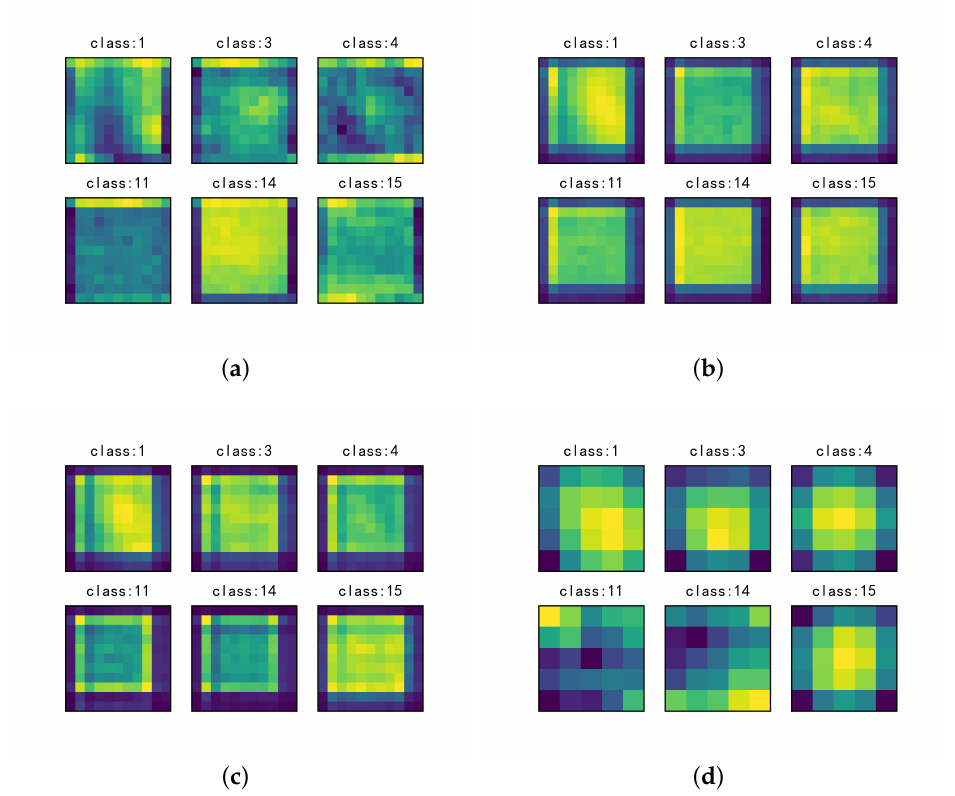
Figure 13. Averaged spatial dimension stimulus value for the six classes in different SpatialSE blocks: ( a ) SpatialSE 1; ( b ) SpatialSE 2; ( c ) SpatialSE 3; and ( d ) SpatialSE